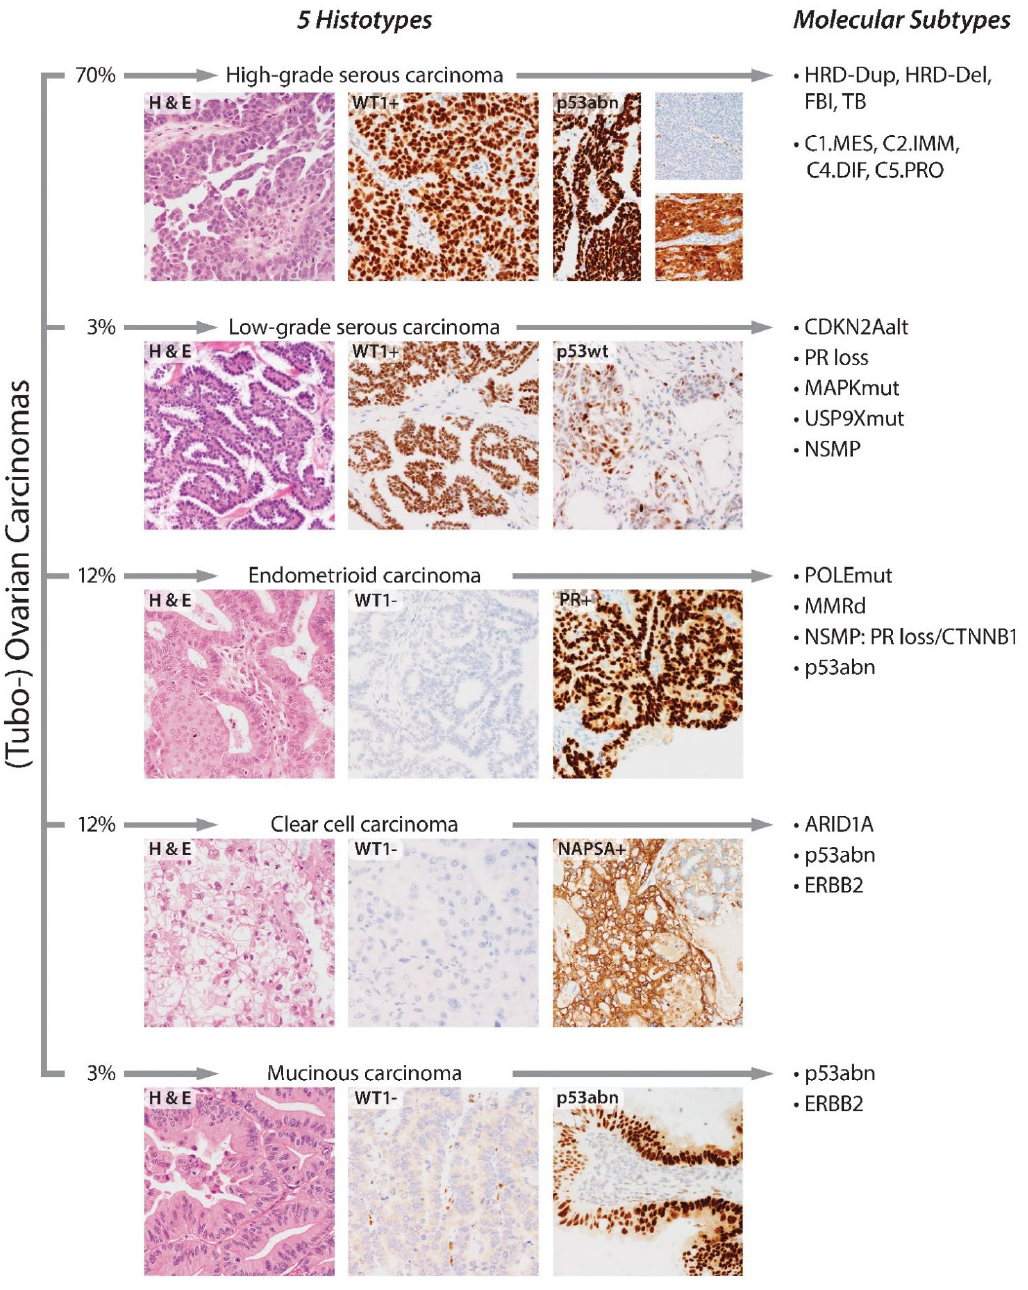
Figure 1. Stratification of (tubo-)ovarian high-grade serous, low-grade serous, endometrioid, clear cell and mucinous carcinoma histotypes into molecular subtypes. NAPSA = napsin A; HRD = ho- mologous repair deficiency; Dup = BRCA1 -associated tandem duplications; Del = BRCA2 -associated interstitial deletions; FBI = fold-back inversions; TD = tandem duplications; CDKN2A alt = CDKN2A alterations; MAPKmut = MAPK pathway mutations; USP9X mut = USP9X mutations; NSMP = no spe- cific molecular profile; POLE mut = POLE mutated; MMRd = mismatch repair deficient; p53abn = p53 abnormal; p53wt = p53 normal/wild